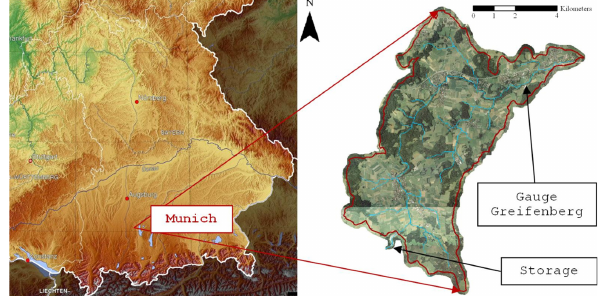
Fig. 2. Location of the northern part of the Windach Catchment with Gauge Greifenberg, retention basin and stream network.